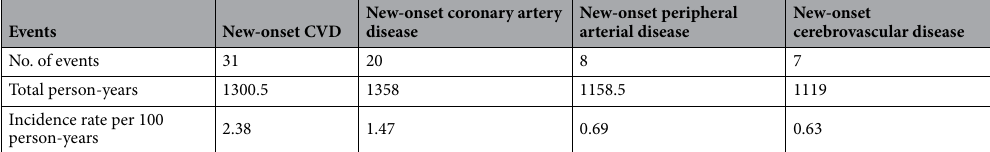
Table 2. Incidence of new-onset cardiovascular disease including coronary artery disease, cerebrovascular disease, and peripheral vascular disease. New-onset CVD includes coronary artery disease or cerebrovascular disease or peripheral arterial